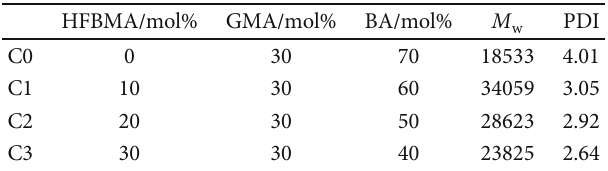
Table 1: Monomer compositions and molecular weight of synthesized